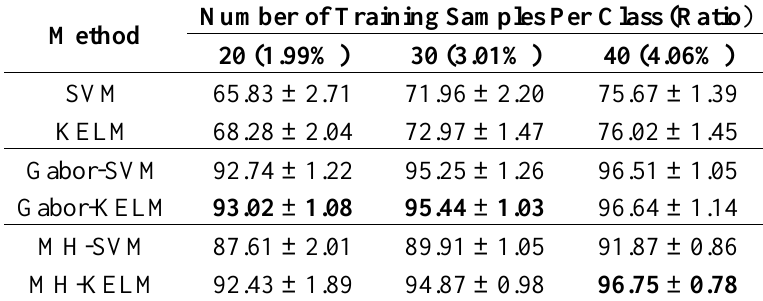
Table 4. Overall classification accuracy (%)—mean ± standard deviation over 10 trials using varying number of labeled training samples (ratio represents the proportion of labeled training samples and samples to be classified) per class for the Indian Pines dataset (nine classes).